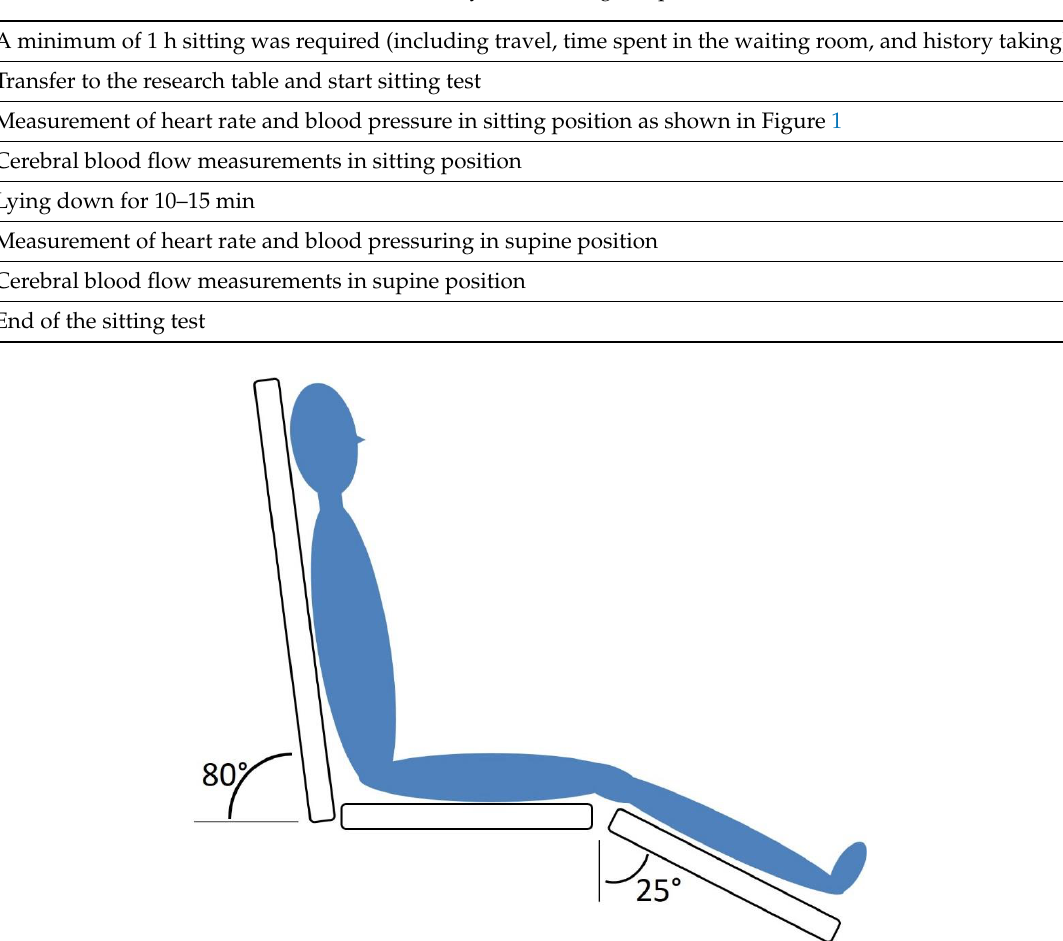
Figure 1. Research setup.